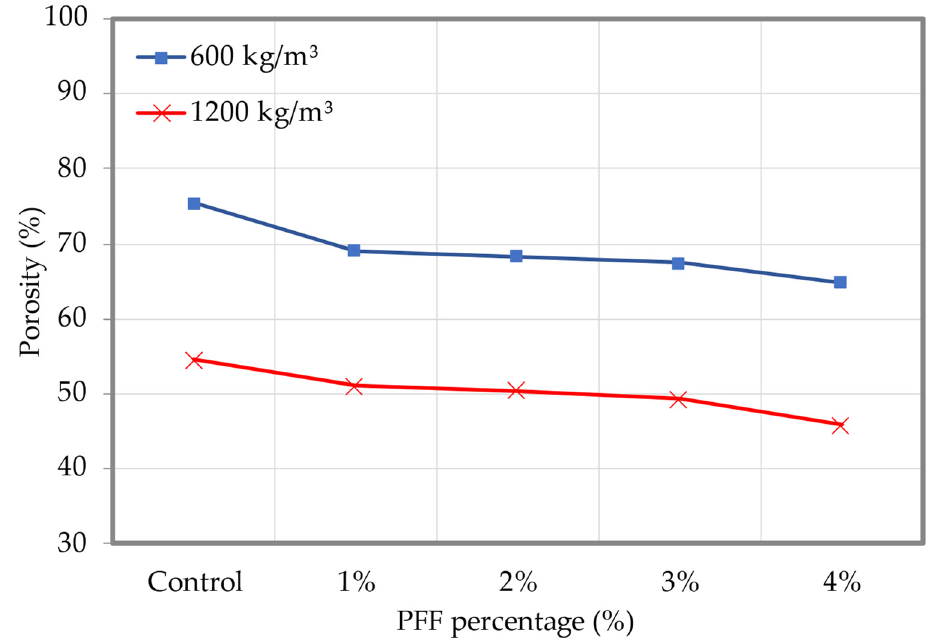
Figure 10. Porosity of foamed concrete with varying percentages of PFF.